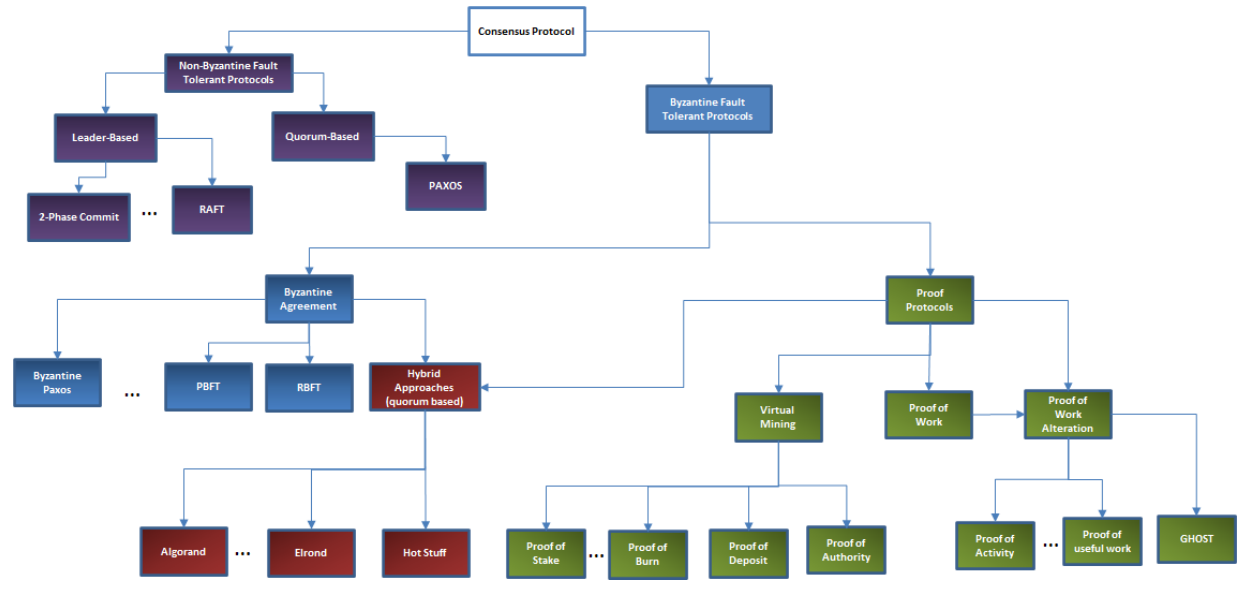
Figure 3. Consensus algorithms taxonomy.